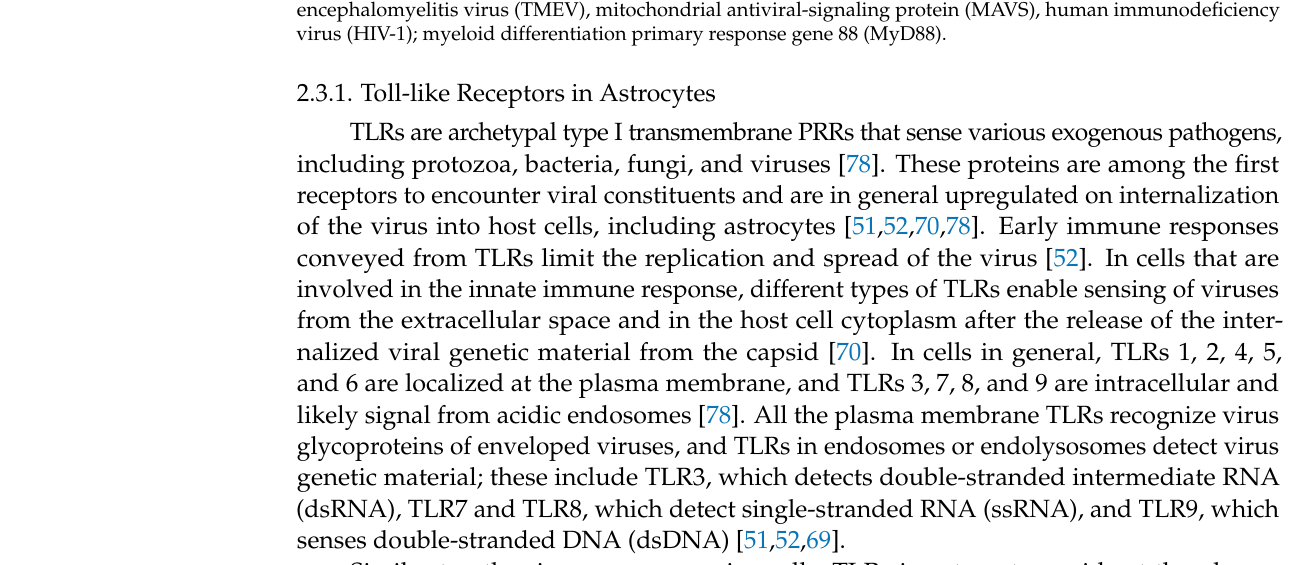
Table 1 delineates known interactions between pattern-recognition receptors (PRRs) and viruses in astrocytes. Note that interactions between NLRs and viruses are unexplored in astrocytes. poly(inosinic